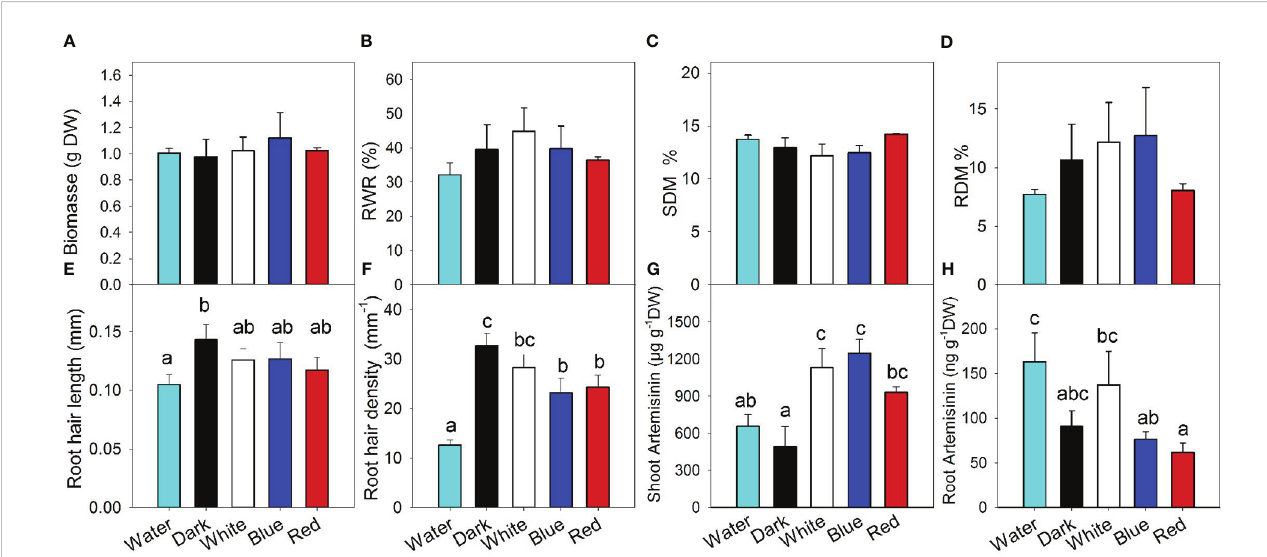
FIGURE 2 The effect of the exposure of Artemisia annua roots to white, blue, and red light on plant biomass (A) , root weight ratio (RWR) (B) , shoot dry matter content (SDM) (C) , root dry matter content (RDM) (D) , root hair length (E) , root hair density (F) , and accumulation of artemisinin in the shoot (G) and roots (H) . “ Water ” treatment corresponds to water culture hydroponics with continuous aeration. Plants in all other treatments were cultivated in aeroponics. Differences between means with different letters are statistically signi fi cant at p<0.05 ( n=4 ). Roots of A. annua were exposed to the light at 31 days after sowing (DAS). The fi nal plant samples were collected at 48 DAS.